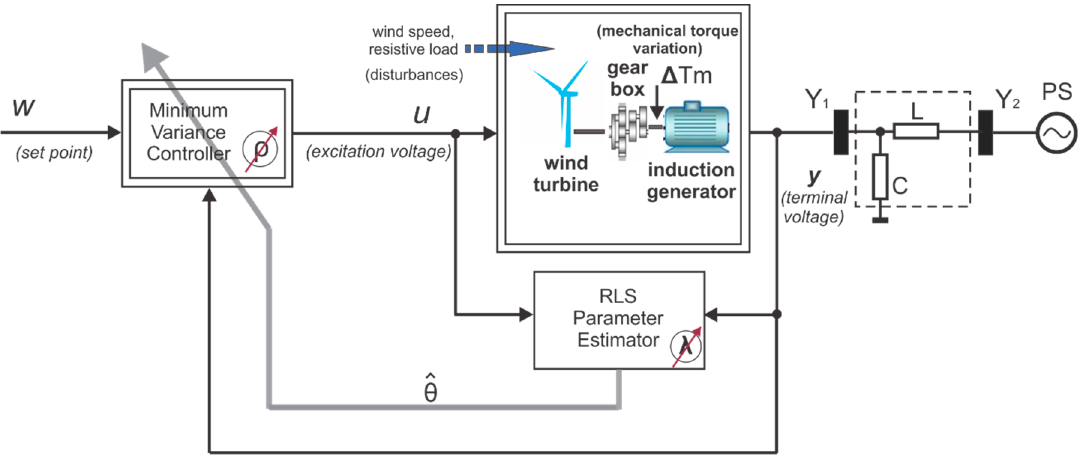
Figure 2. The minimum variance control system for the induction generator.